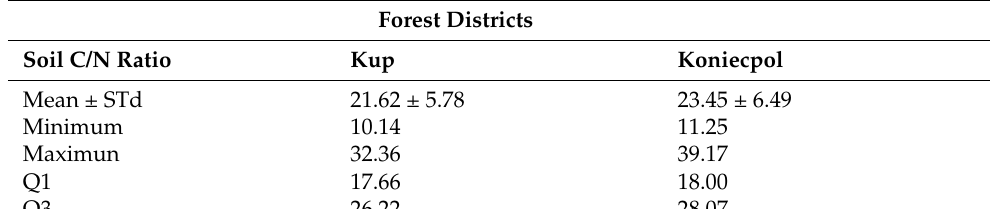
Table 2. Soil C/N ratio and Sentinel-2 derived Normalized Difference Vegetation Index (NDVI) determined in 100 sampling points in the Kup forest district and 99 sampling points in the Koniecpol forest district, in Southern Poland.